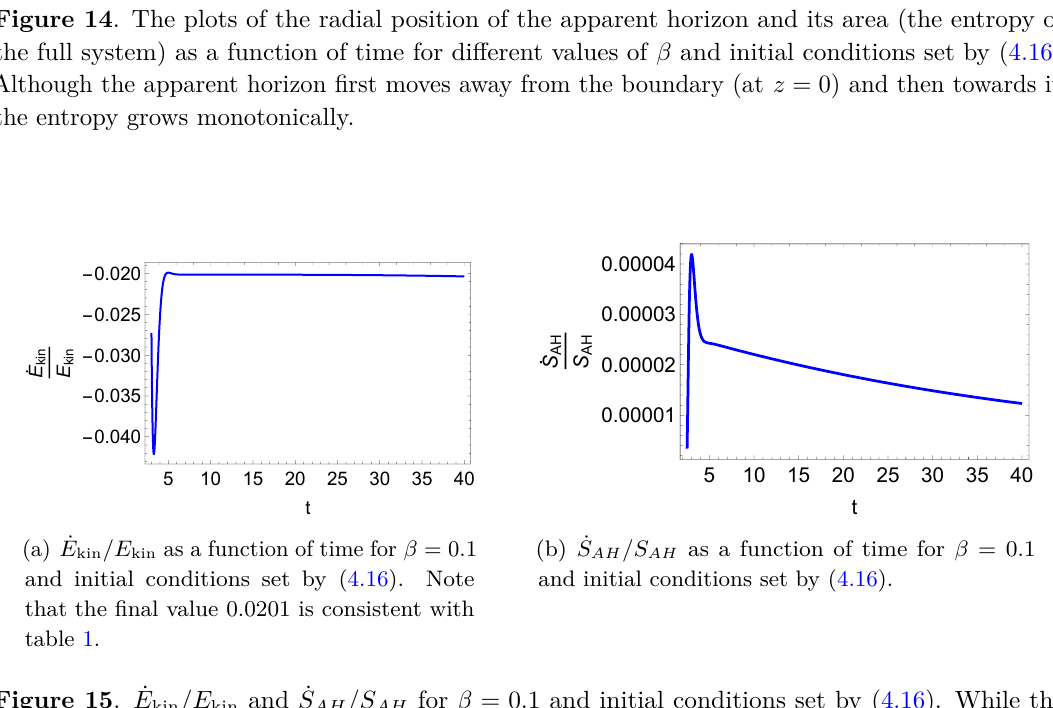
Figure 15 . ˙ E kin /E kin and ˙ S AH /S AH for β = 0 . 1 and initial conditions set by (4.16). While the energy transfer to the bath occurs at a constant rate at late time, the rate of growth of entropy vanishes as it should if the system